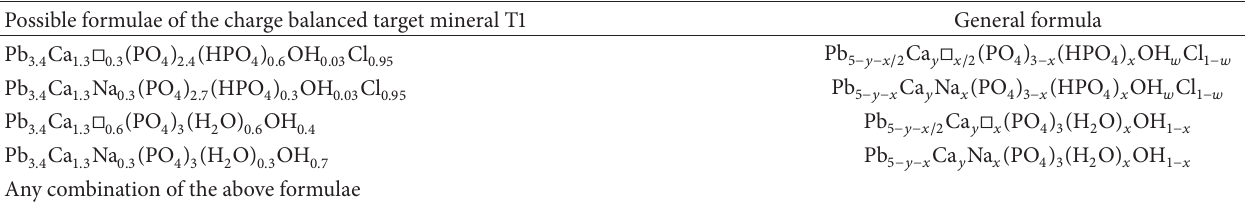
Figure 9: Characterisation of the target minerals, (a) XRD, (b) unit cell graph, (c) FTIR, and (d) TEM (bar markers = 50 nm). Table 3: Possible formulae of target mineral T1 together with general formulae. Divalent cation vacancies are denoted by the symbol ◻ . Formulae containing carbonate are more complex and are not